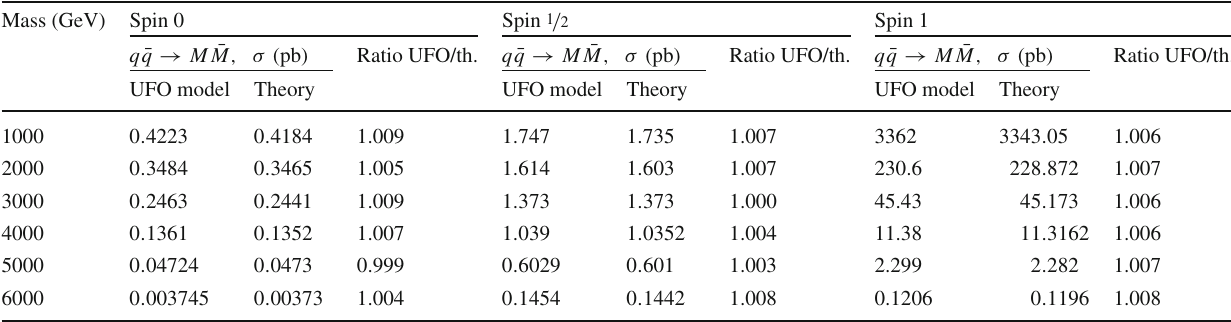
Table 2 Cross-section values obtained from theoretical calculations Drell–Yan production mechanism. The ratios simulation/theory predic- √ s γγ = 13 TeV without PDF and from the MadGraph UFO model at tion are also listed for monopoles of spin 0, 1 / 2 , 1 and a β -dependent coupling through the Mass (GeV) Spin 0 Spin 1 /